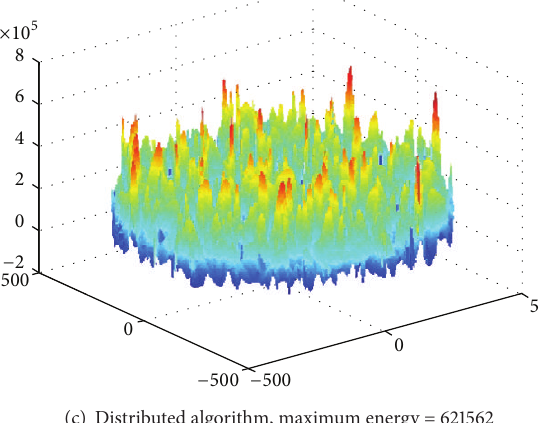
Figure 34: Experimental results comparison of static sink, centralized algorithm, and distributed